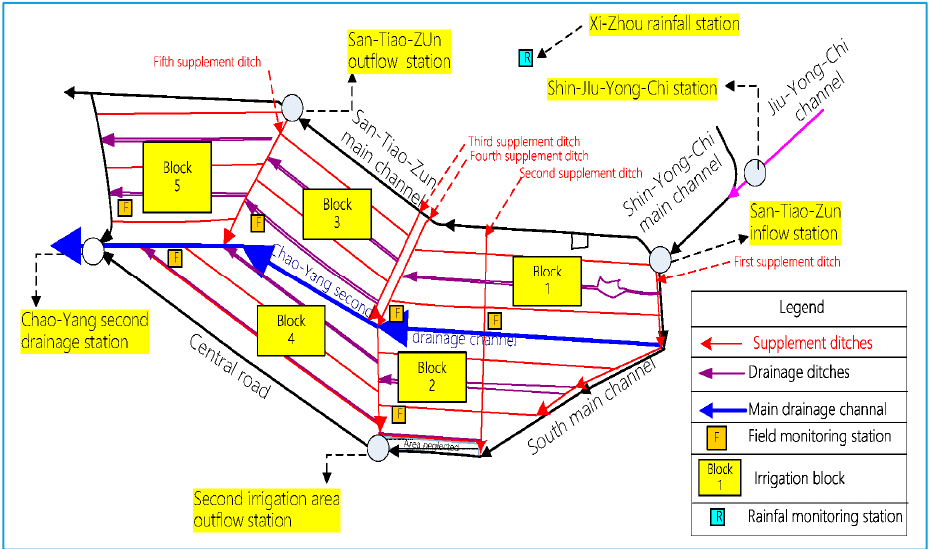
Figure 6. Layout of blocks, drainage, and irrigation channels.